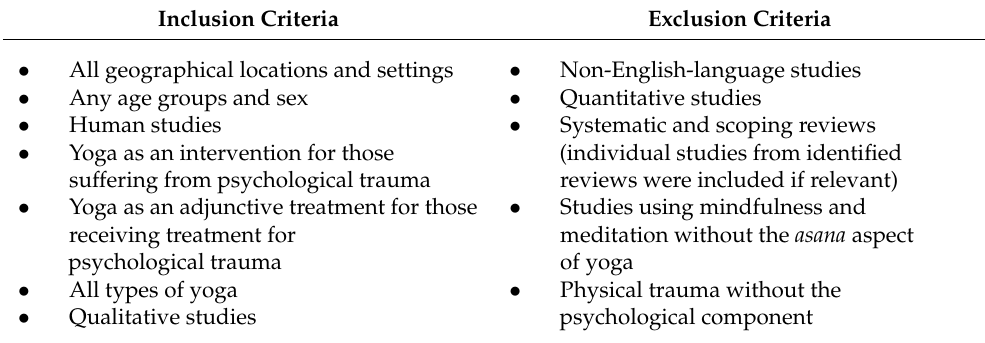
Table 2. Eligibility